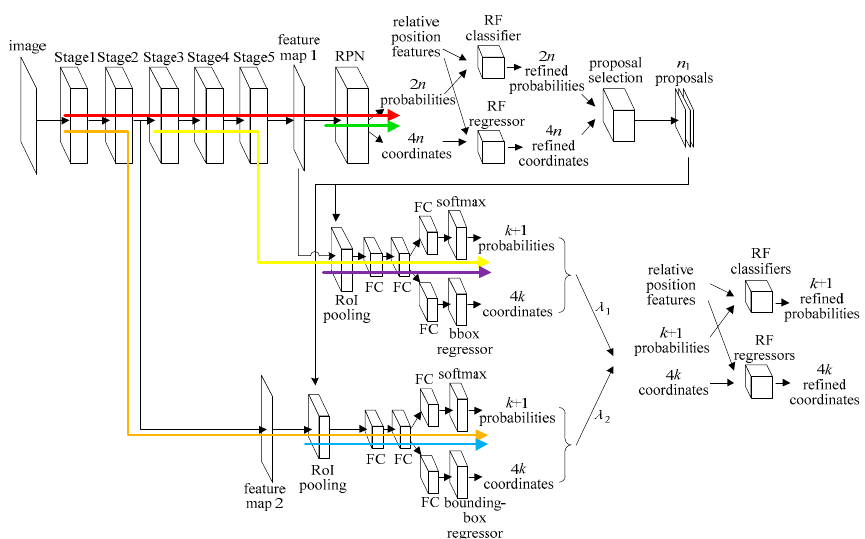
Figure 5. The training process of the neural network.